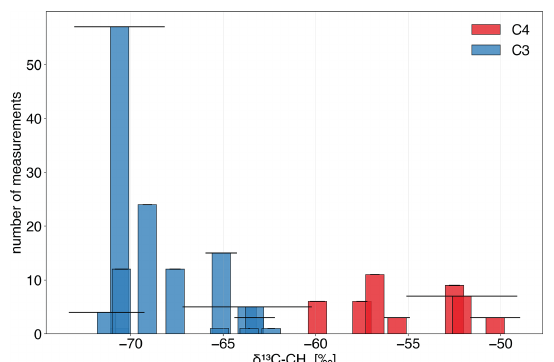
signatures from ruminants in the Figure A1. Measured δ 13 C CH 4 literature studies (Al-Shalan et al., 2022; Brownlow et al., 2017; Klevenhusen et al., 2009, 2010; Levin et al., 1993; Lu et al., 2021; Rust, 1981; Townsend-Small et al., 2012; Wahlen et al., 1989) ac- cording to the feed: a majority of C 3 plants (blue) or C 4 plants (red). Bar heights represent the number of measurements and black lines standard deviations.